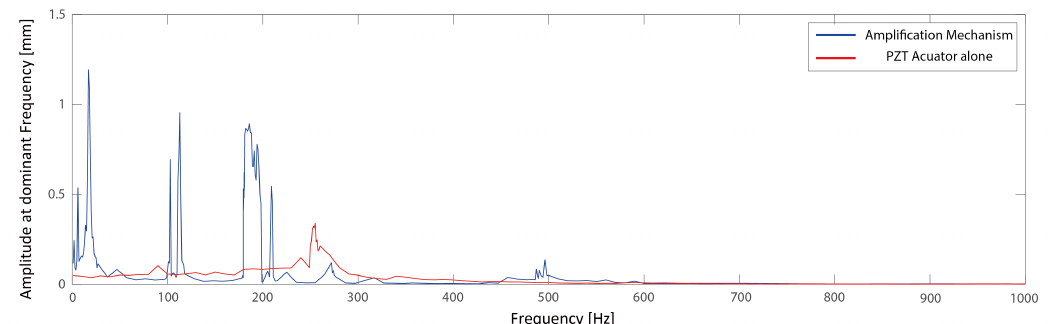
Figure 8. Comparison between amplification mechanism and piezoelectric actuator alone for amplitude of dominant oscillations versus driving frequency.